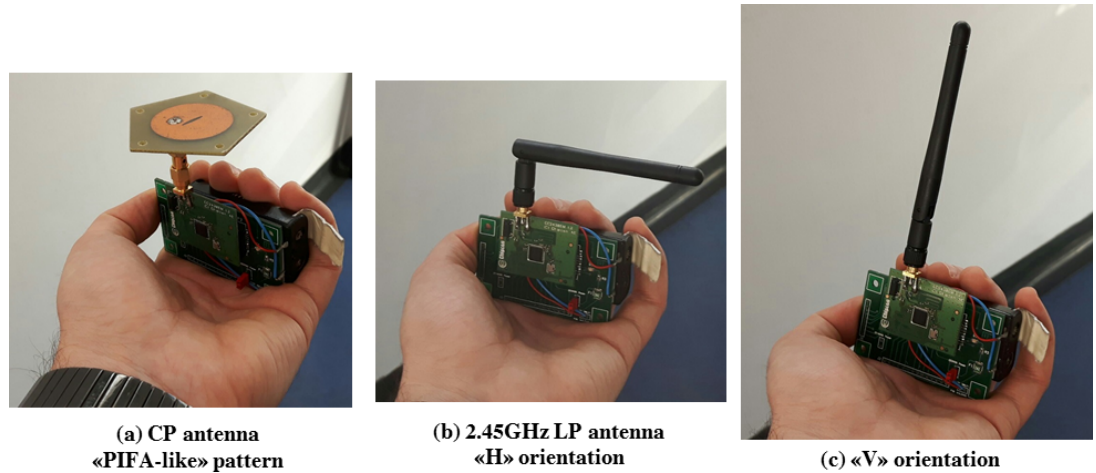
Figure 21. Tracking tests different antenna configurations.